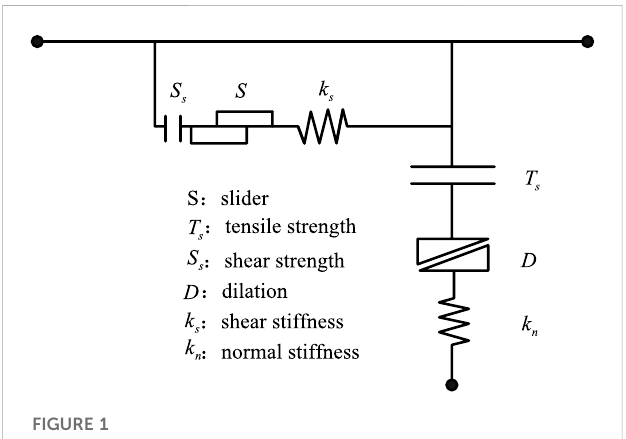
FIGURE 1 Components of the bonded interface constitutive model.